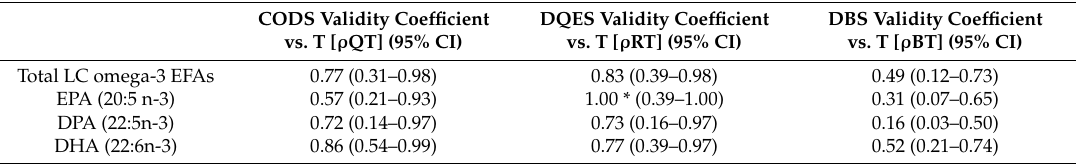
Table 4. Validity coefficients ( ρ) calculated using the method of triads for each of the methods vs. the estimated true intake (T) for each of the long-chain omega-3 EFAs.